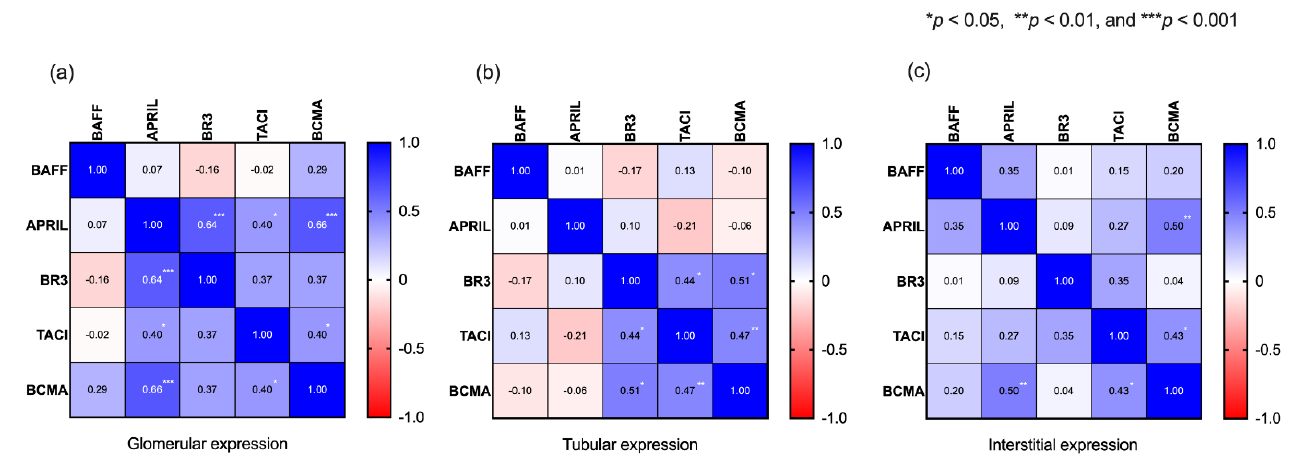
Figure 4. Matrix correlations of BAFF system expression according to zones. At the glomerular level, APRIL showed a positive correlation between all BAFF system receptors, and TACI correlated with BCMA ( a ). On the other hand, BR3, TACI, and BCMA showed a positive correlation at the tubular level ( b ). BCMA expression in the interstitium had a positive correlation with APRIL and TACI ( c ). The p -value was obtained through a Spearman rank correlation test. BAFF: B-cells activating factor, APRIL: A proliferation-inducing ligand, BR3: BAFF receptor, TACI: Transmembrane activator and CALM interactor, BCMA: B-cell maturation antigen.